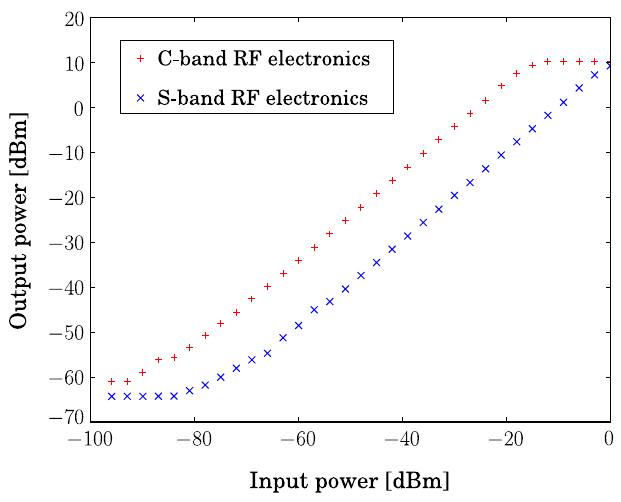
FIG. 6. The linearity of C - and S -band electronics.